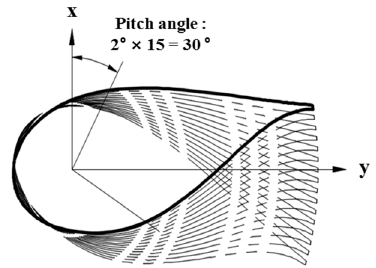
Figure 3. Section view for blade pitch angle.